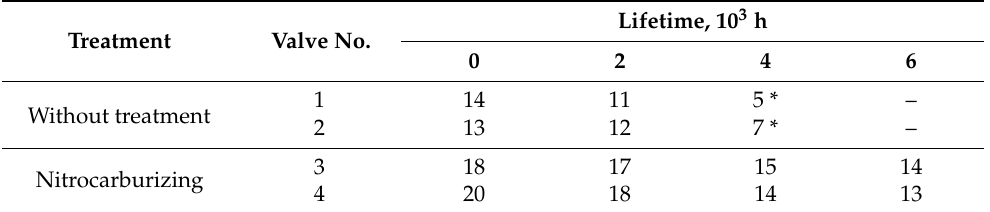
Table 6. Tightness of valves,